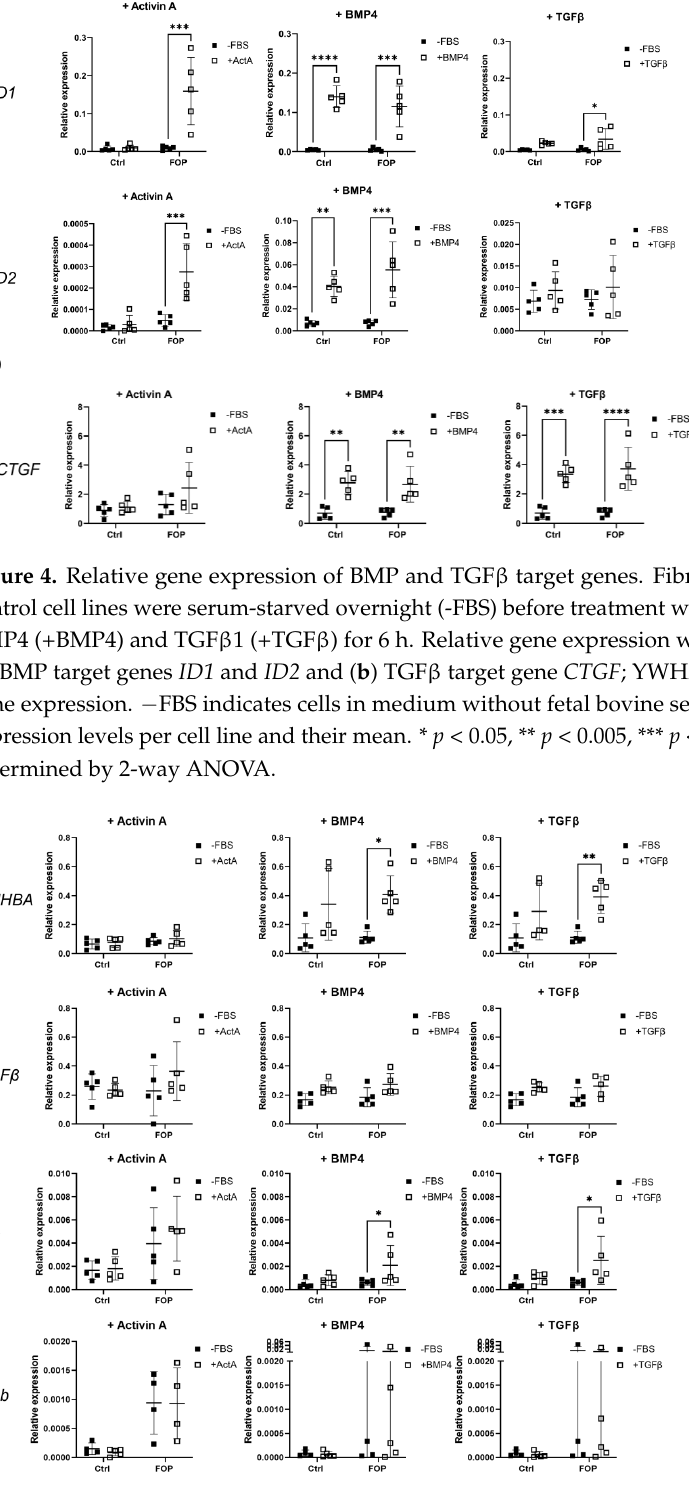
Figure 5. Relative gene expression of cytokines. Fibroblasts from 5 FOP and 5 control cell lines were serum-starved overnight ( − FBS) before treatment with Activin A (+Activin A), BMP4 (+BMP4) and TGF β 1 (+TGF β ) for 6 h. Relative gene expression was measured by qPCR for INHBA , TGFBR1 , IL6 , and IL1b ; YWHAZ was used to normalize gene expression. Data is shown as the expression levels per cell line and their mean. * p < 0.05, ** p < 0.005 as determined by 2-way ANOVA.